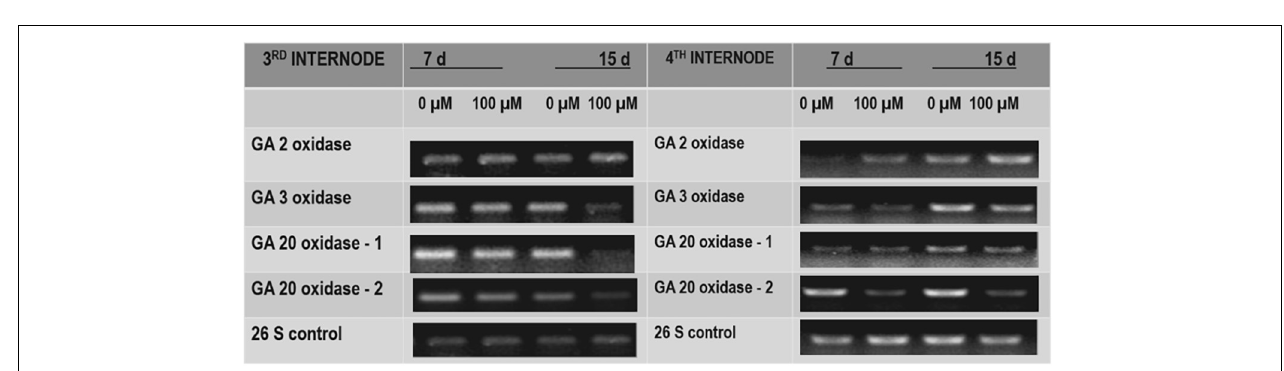
FIGURE 9 | The effects of TDZ on the abundance of transcripts for gibberellic acid (GA) 2 oxidase, GA3 oxidase, and GA20 oxidase. The third and fourth internodes from the base were harvested at 7 and 15 days after TDZ treatment for RNA extraction and semiquantitative PCR analyses.